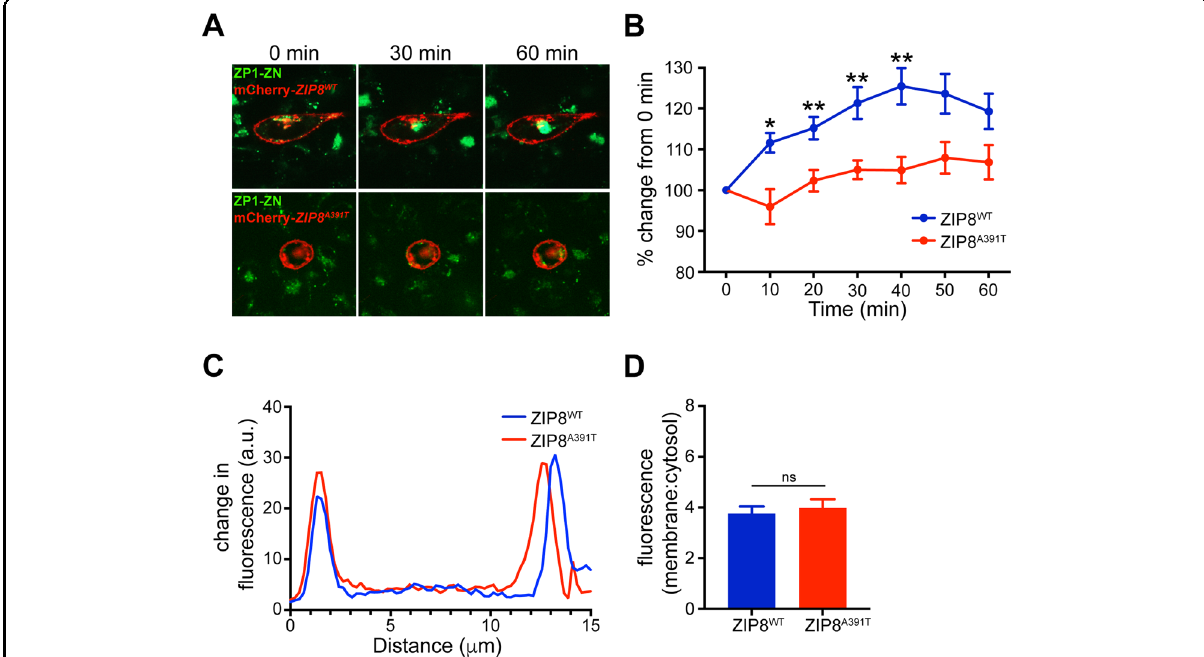
Fig. 1 Human ZIP8 A391T SNP associated with schizophrenia is a loss-of-function allele. A Time course of ZP1 signal after addition of ZnCl 2 in CHO cells overexpressing either ZIP8 WT or ZIP8 with the human SNP mutation ( ZIP8 A391T ) tagged with mCherry. B Quanti fi cation of GFP signals over time relative to 0 min for both ZIP8 WT - and ZIP8 A391T -overexpressing CHO cells. The baseline measurements ( T 0) of ZIP8 WT and ZIP8 A391T were not signi fi cantly different (unpaired t -test, P = 0.11). Compared to ZIP8 WT , ZIP8 A391T -expressing CHO cells had signi fi cantly lower ZnCl 2 in fl ux at multiple timepoints. P = 0.003 (two-way ANOVA, n = 25 – 32 per condition). Bonferroni ’ s post-hoc test revealed signi fi cant differences at 10, 20, 30, and 40 min (* P = 0.02, ** P < 0.01). Error bars, SEM. C , D Overexpression of ZIP8 WT or ZIP8 A391T did not alter cell size (representative traces of cell size measurements shown in C ). D Quanti fi cation of the membrane:cytosol signal. Ten cells from each group were used for quanti fi cation. Error bars,